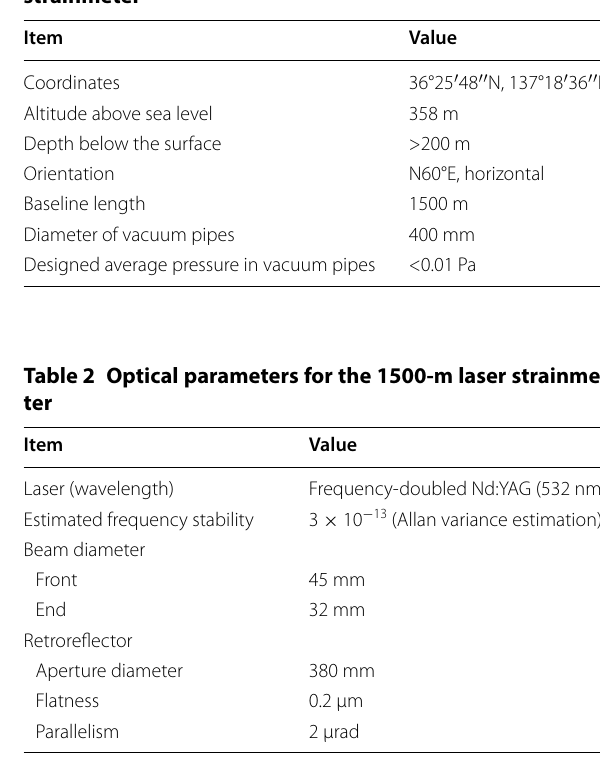
Table 1 Configuration parameters of the 1500-m laser strainmeter